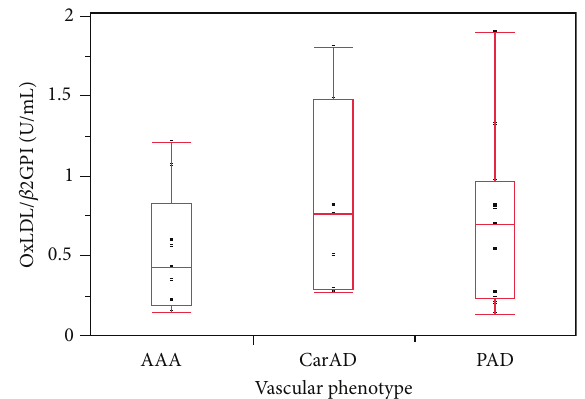
Figure 1: Distribution of serum levels of oxLDL/ 𝛽 2GPI complexes measured by ELISA in 48 healthy controls and 25 patients with venous and 27 with arterial diseases ( 𝑛 = 27 ). Subjects taking statins were excluded. Mean oxLDL/ 𝛽 2GPI levels in arterial ( 0.69 ± 0.50 U/mL, 𝑃 = 0.004 ) and venous diseases ( 0.54 ± 0.37 U/mL, 𝑃 = 0.025 ) were significantly higher than healthy controls ( 0.39 ± 0.33 U/mL). Mean levels in arterial ( 0.69 ± 0.50 U/mL) versus venous diseases ( 0.54 ± 0.37 U/mL) were not statistically different ( 𝑃 = 0.394 ). OxLDL/ 𝛽 2GPI levels among the three groups were statistically significant ( 𝑃 = 0.006 , Wilcoxon/Kruskal-Wallis Rank Sum test). Boxes represent 75/25 percentiles with the horizontal line the median for the group and whiskers the 90/10 percentile bars.